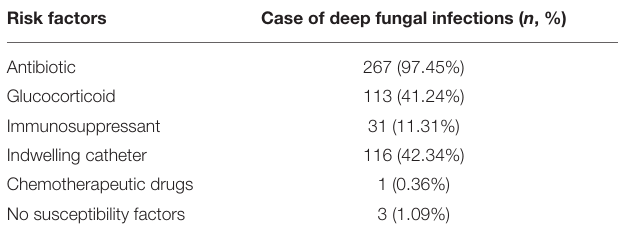
TABLE 2 | Percentage of risk factors in patients with deep fungal infections.